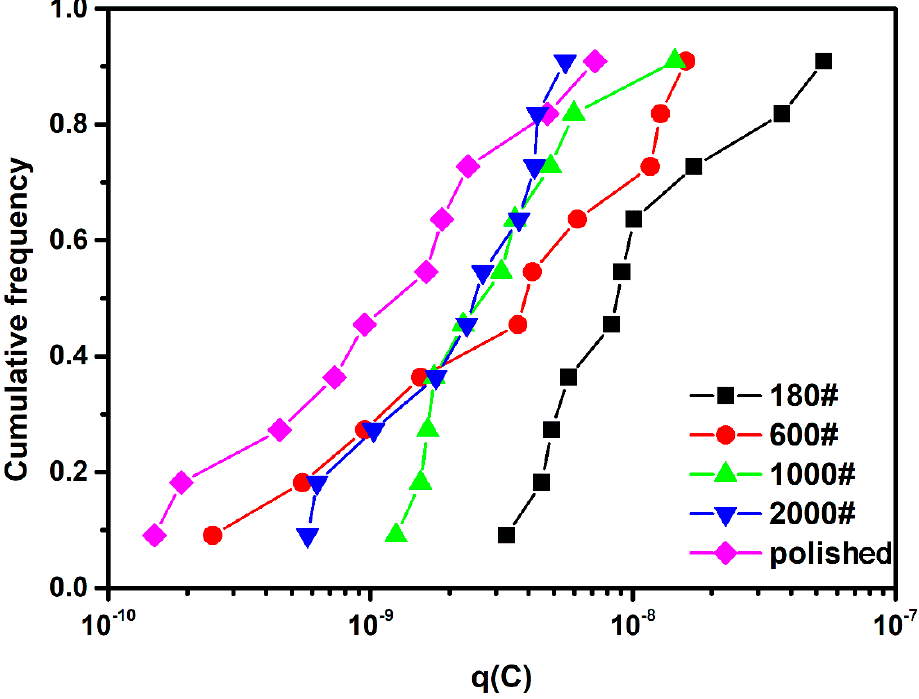
Figure 8. Cumulative frequency of q for different surface roughness DSS 2205 specimens in 10% FeCl 3 at 50 °C.